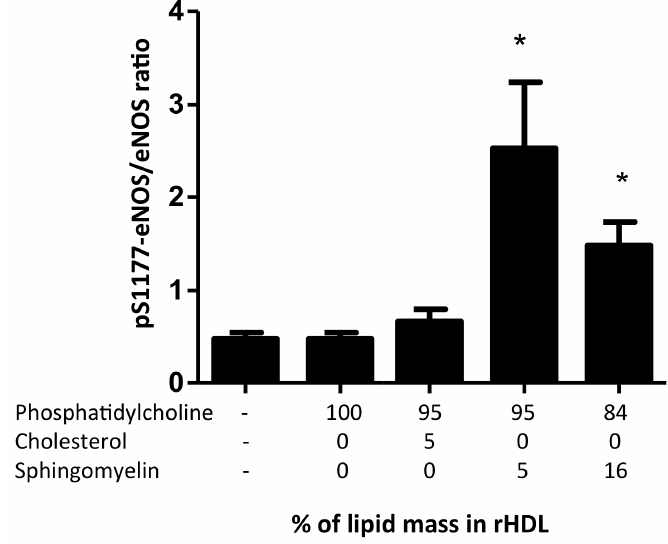
Figure 6. Phosphorylation of eNOS at S1177 after incubation with rHDL reconstituted with different lipid content (indicated in the horizontal axis). HMEC-1 was incubated for 20 min with rHDL containing different lipid proportions. Total eNOS and S1177-phosphorylated eNOS were determined by confocal microscopy using secondary antibodies labeled with Alexa Fluor 405 (blue) and fluorescein isothiocyanate (FITC, green), respectively. Bars represent the ratio of the fluorescence determined for S1177-phosphorylated eNOS (pS1177-eNOS) and the fluorescence of total eNOS detected. Fluorescence was adjusted by cell area and background and expressed as mean ± SD of three independent experiments. * p < 0.005 vs. control.